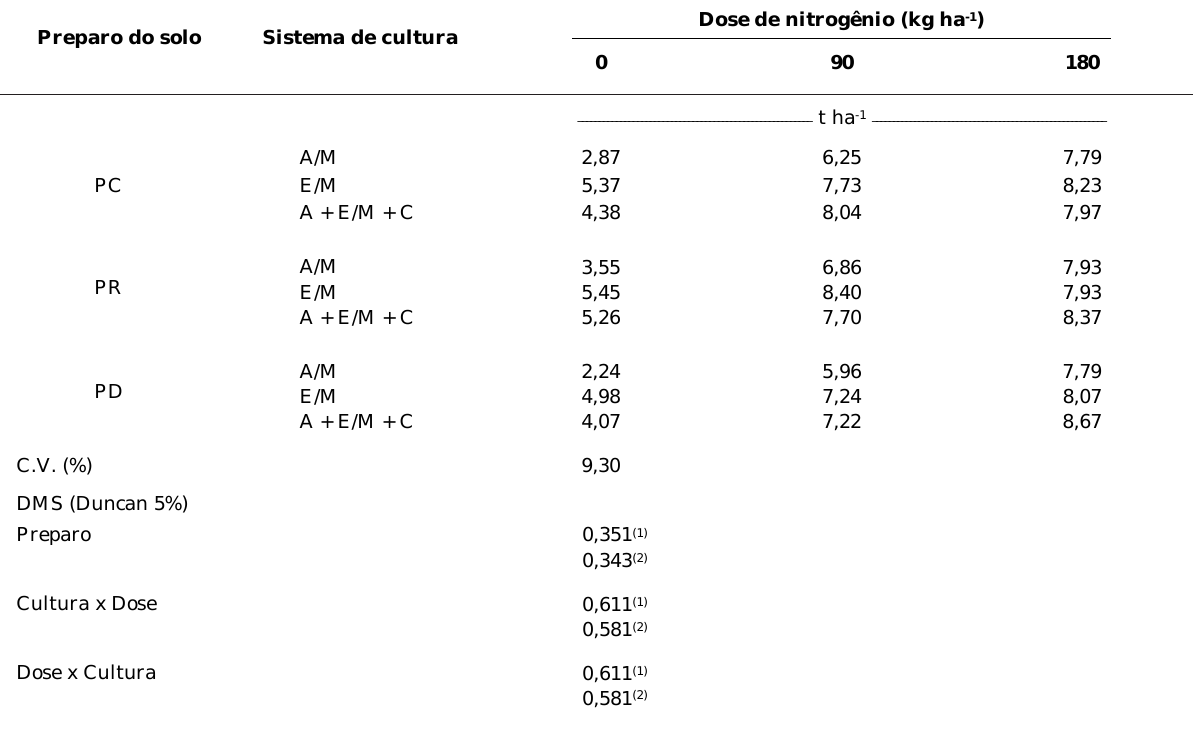
figura 4. No sistema A/M, houve resposta significativa às duas doses de N aplicado, o mesmo ocorrendo com a consorciação A + E/M. No sistema E/M, somente houve resposta significativa até à